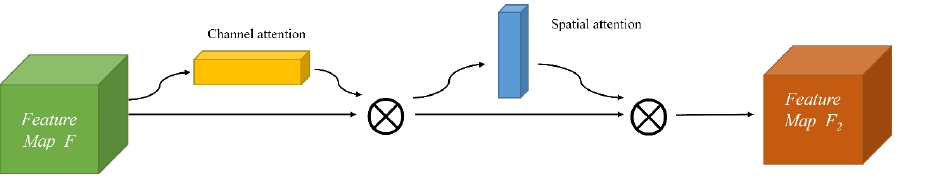
Figure 3. Enhanced dataset images. Table 1. Dataset of maize seeds (double-sided mixture).